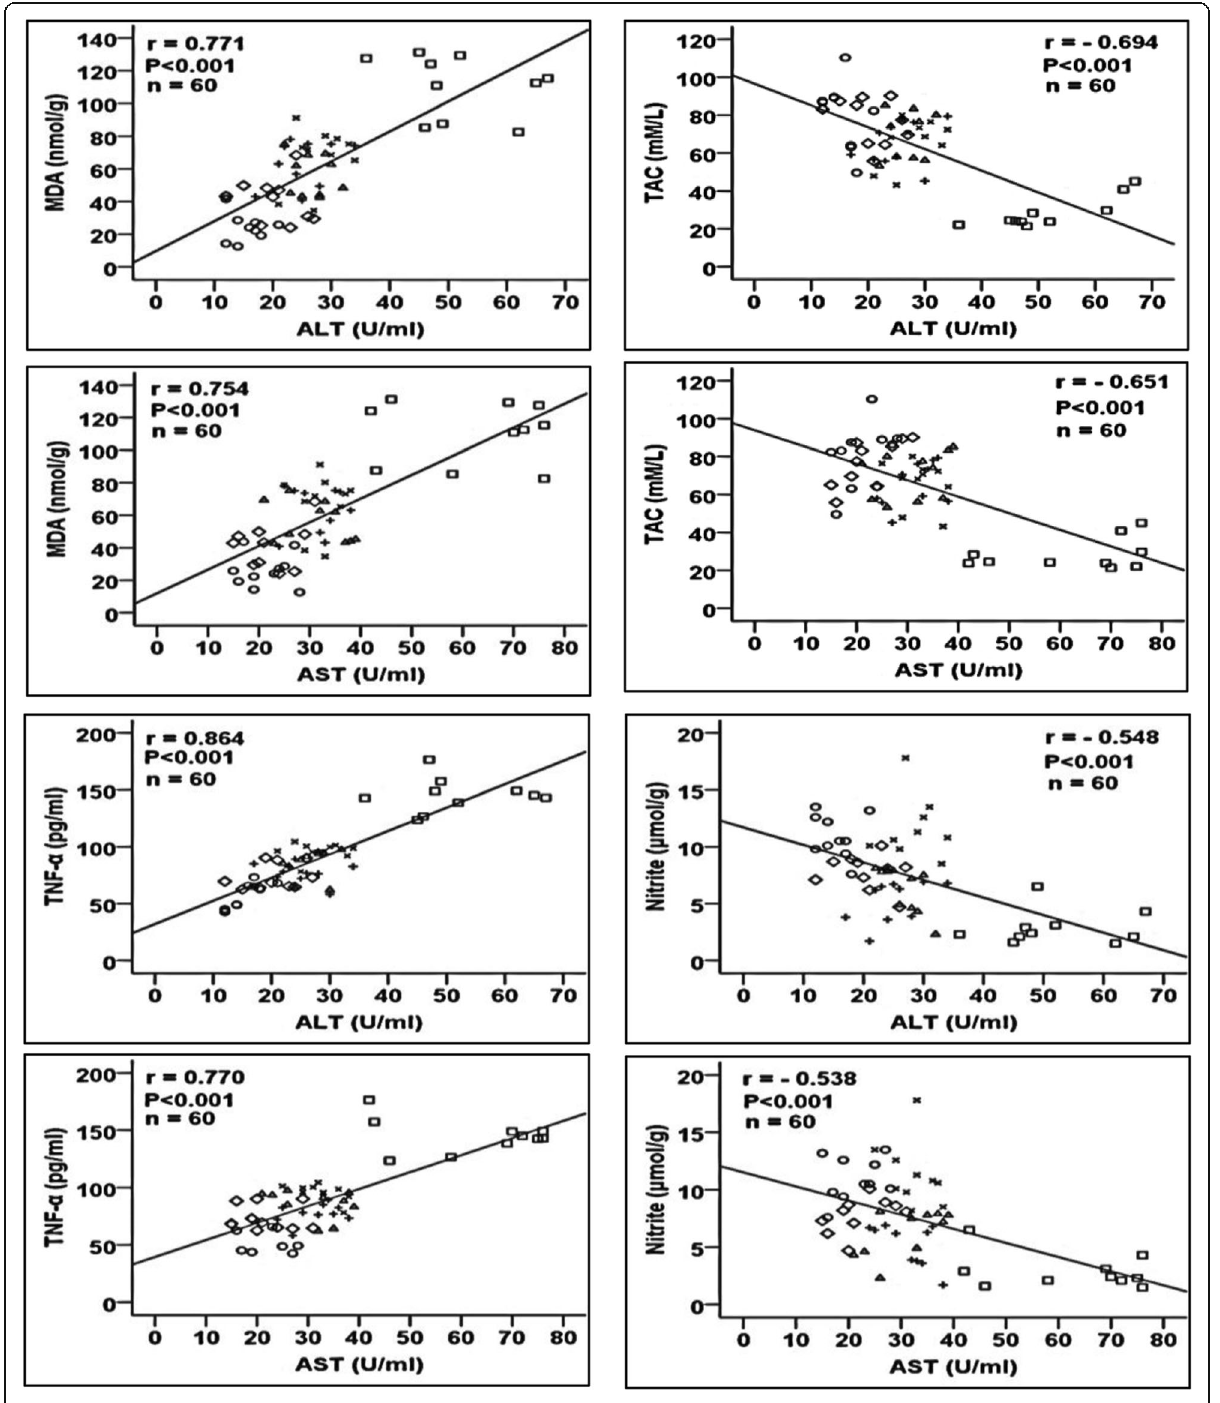
Fig. 3 Correlations between the serum levels of alanine transferase (ALT), aspartate transferase (AST), and plasma levels of malondialdehyde (MDA), total antioxidant capacity (TAC), tumor necrosis factor-alpha (TNF- α ), and nitrite in the different studied groups. o Sham-operated control group. □ Hepatic ischemia-reperfusion group. x L -arginine-treated hepatic ischemia-reperfusion group. Δ Exercise-trained hepatic ischemia- reperfusion group. + Oxytocin-treated hepatic ischemia-reperfusion group. ◊ Exercise-trained and oxytocin-treated hepatic ischemia-reperfusion